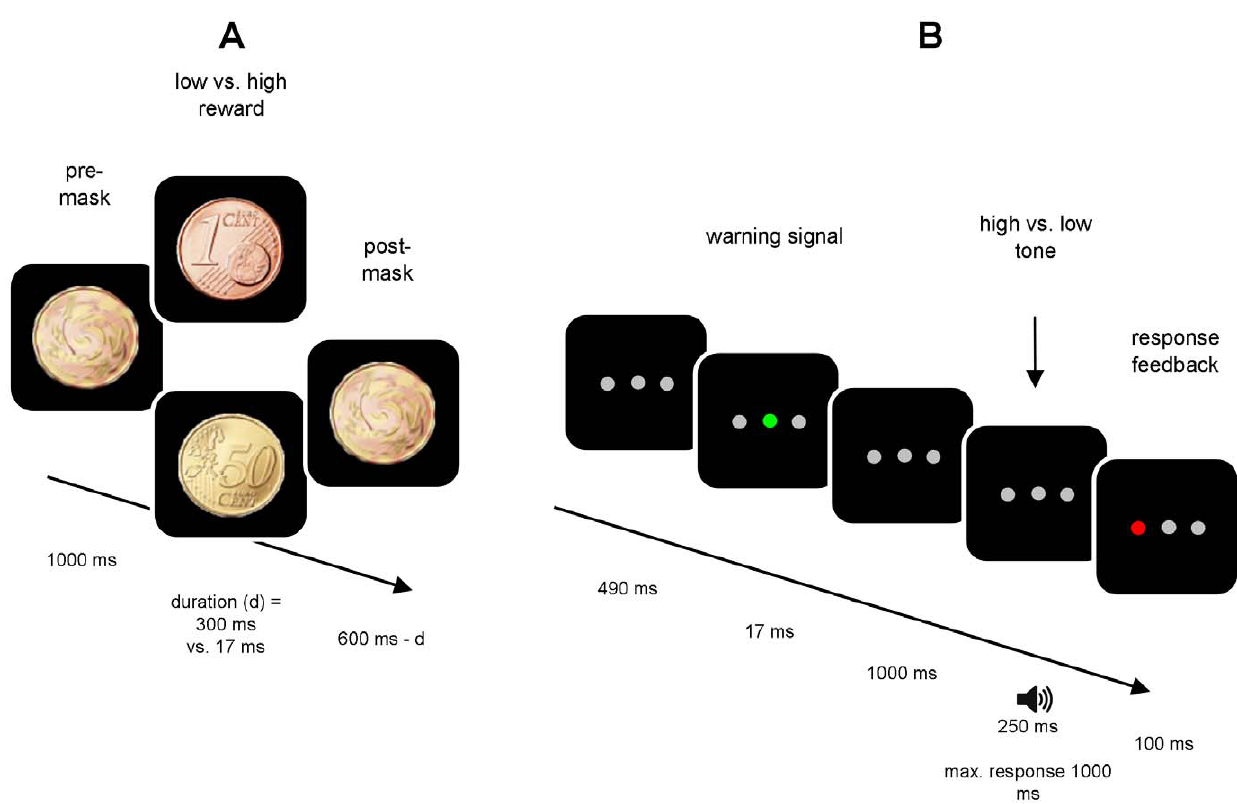
Figure 1. Schematic overview of the experimental task. Each trial started with the presentation of a reward, sandwiched between a pre- and a post-mask (A), followed by two repetitions of the auditory Simon task (2 6 B). Between the two repetitions, a blank screen was presented for the duration of 1500 ms minus the time of the response to the first tone (if the response time exceeded 1500 ms, the task would continue automatically).